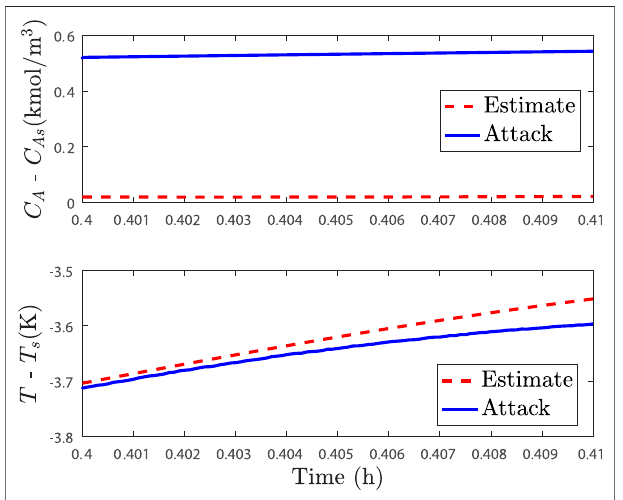
FIGURE3| Comparison betweentheclosed-loop statetrajectoryunder attack (solid line) and the closed-loop state estimate trajectory (dashed lines) over one sampling period after 0.4 h of operation under the state feedback LEMPC.